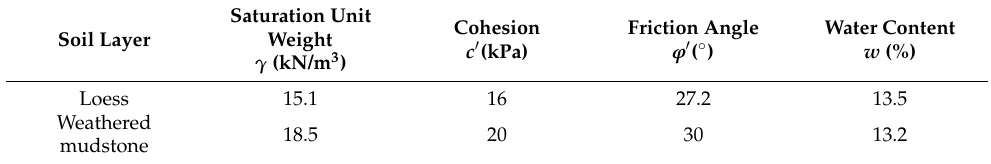
Table 2. Shear strength properties of soil.